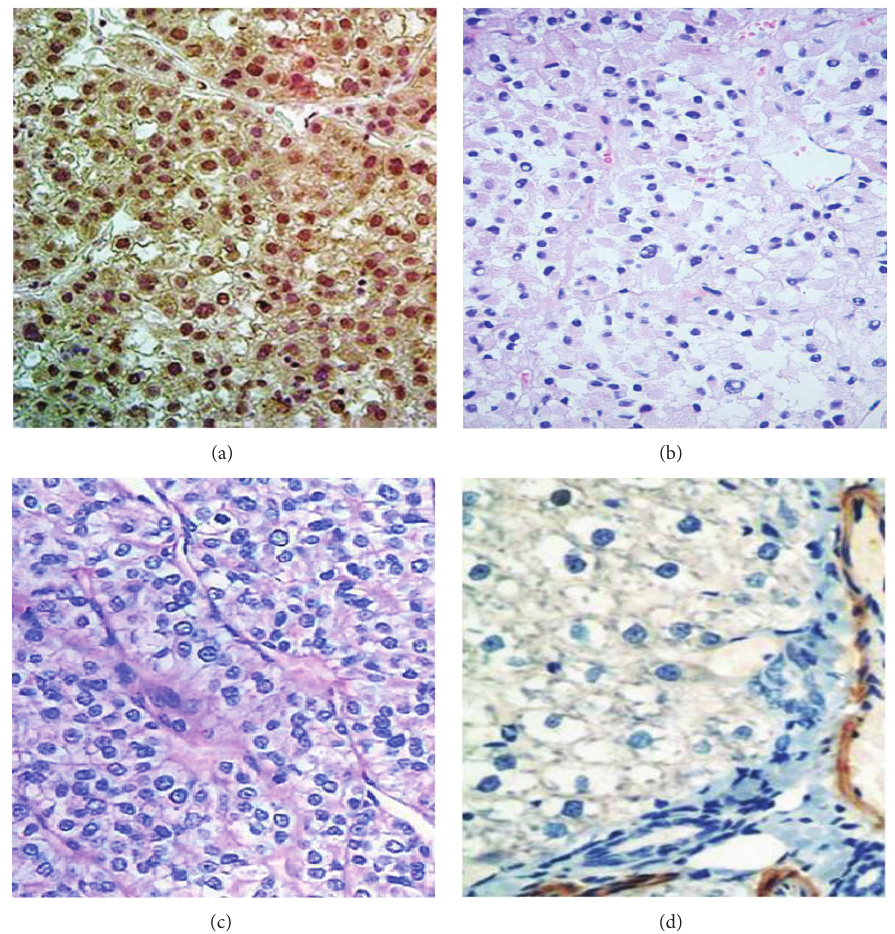
Figure 1: Representative images showing the presence of SALL4 protein in liver cancer and noncancerous tissue sections. (a) The positive expression of SALL4 in hepatocellular carcinoma tissues (the scoring is 2+); (b) the negative expression of SALL4 in liver tissues with chronic hepatitis B virus; (c) the negative expression of SALL4 in liver samples with liver cirrhosis; and (d) the negative expression of SALL4 in liver samples of health controls. (400x